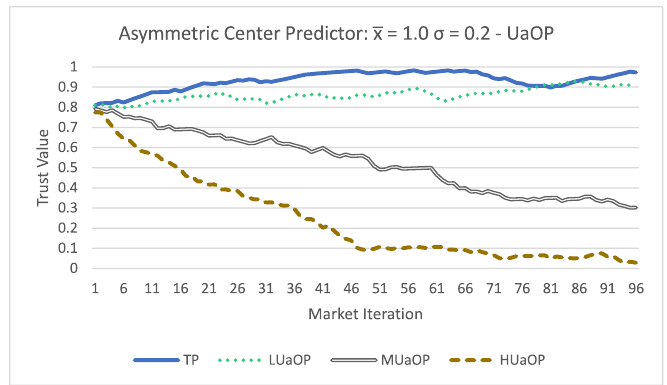
Figure 5. Asymmetric Low